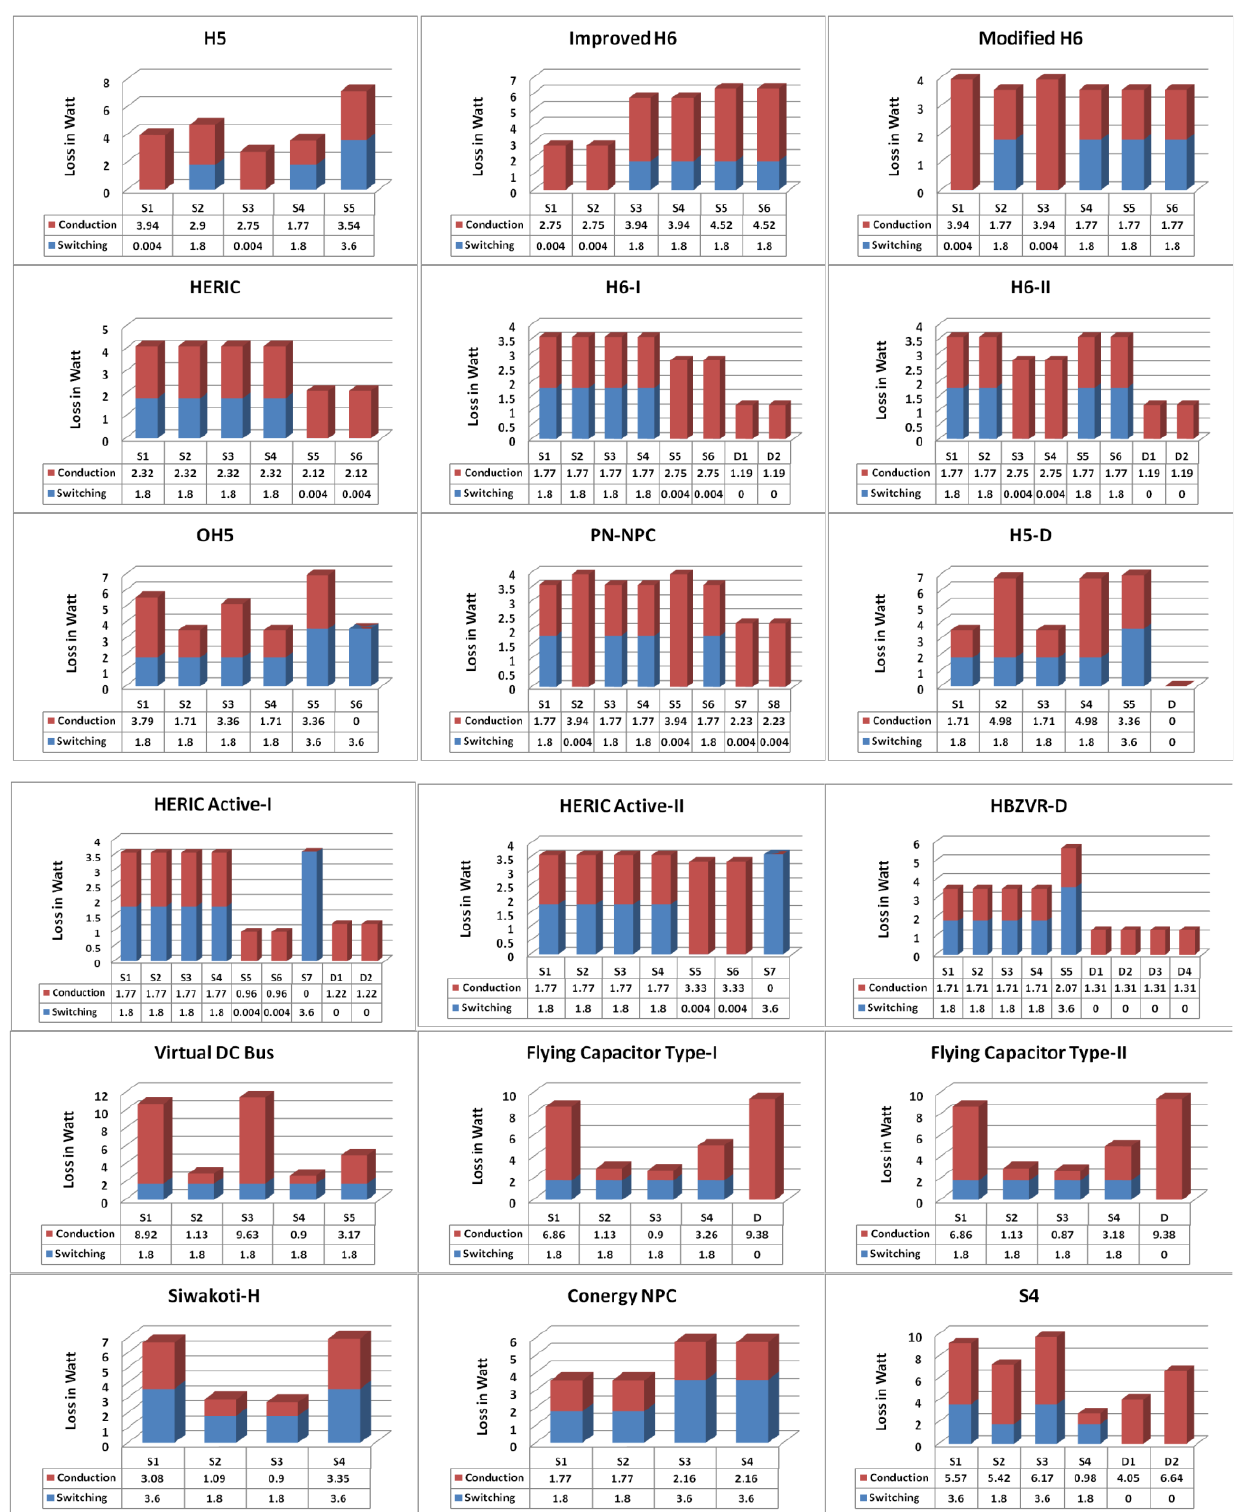
Figure 25. Power loss distribution across each of the switches of all the chosen eighteen topologies for output power of 998.2 W. Table 4. Comparison of the selected topologies based on simulation results and physical parame- In Figure 26, the output power versus efficiency curve for three chosen topologies—one ters. from each category—is